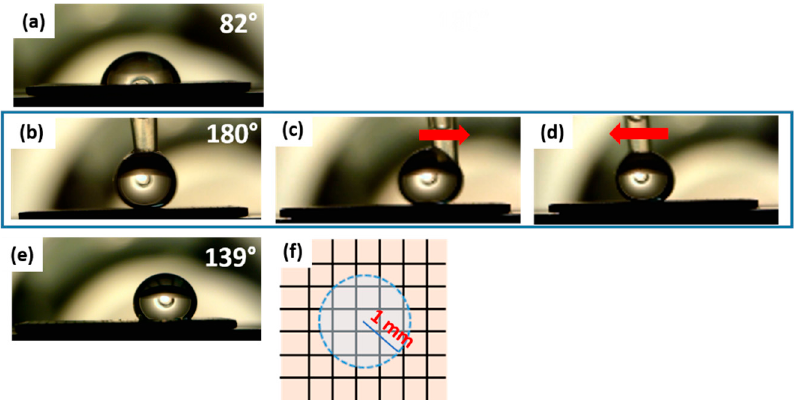
Figure 3. Images of the 10 µ L droplet deposited on ( a ) the pristine surface and on ( b ) the laser-textured surfaces ( h = 50 µ m). The snapshots show the dynamic of the droplet, which can be moved right ( c ) and left ( d ). ( e ) A 10 µ L droplet on the textured surface h = 500 µ m with ( f ) the schematic upper view, the blue dotted line represents the contour of the droplet and is in touch with the textured material.